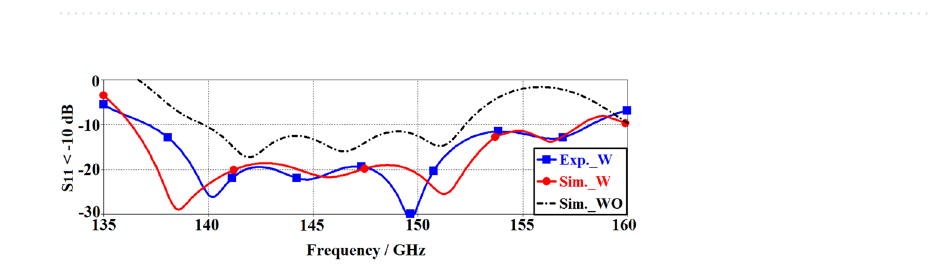
Table 1. Structural dimensions of OCA ( unit : µ m ).